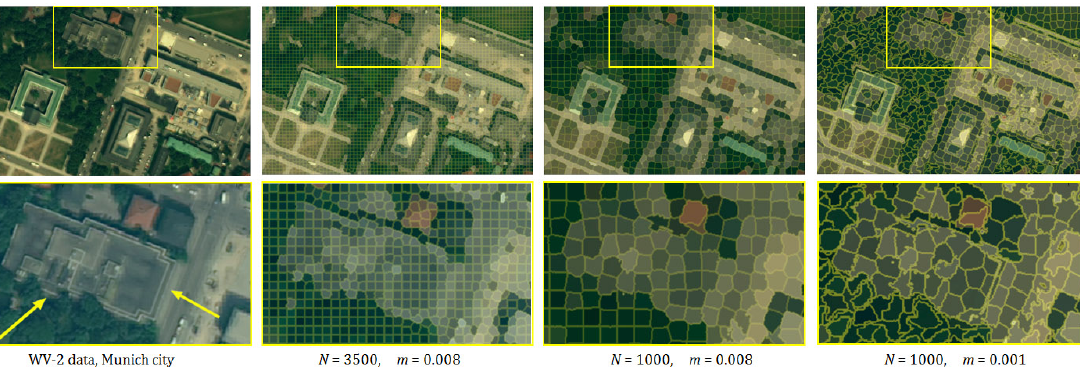
Figure 2. Results of SLIC superpixels on a sample WV-2 urban scene. The algorithm tends to fail on weak boundaries which are pointed by